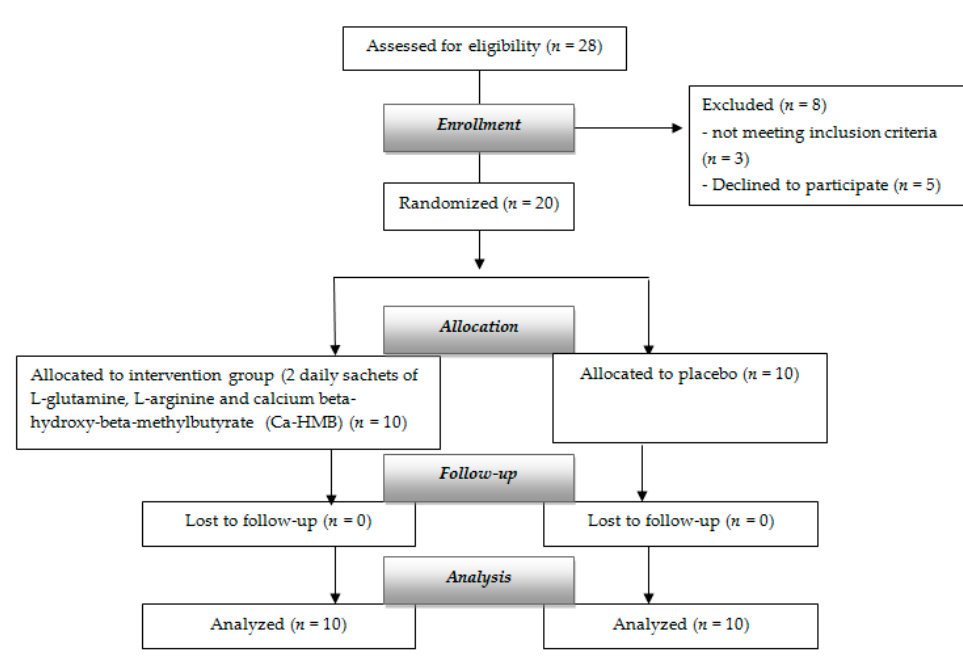
Figure 1. Flow chart of the study.